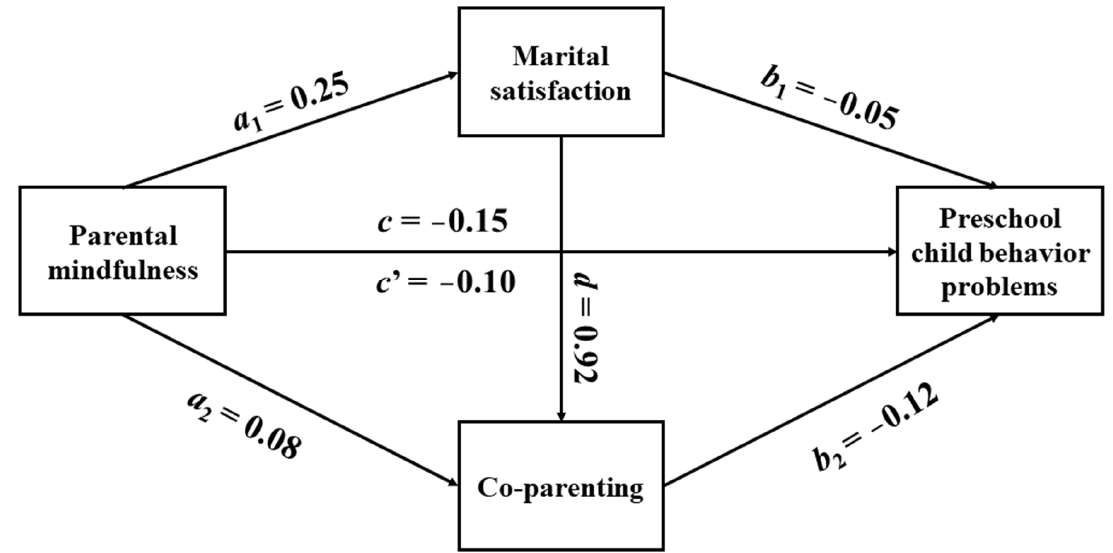
Figure 1. The pathway of the mediating model.